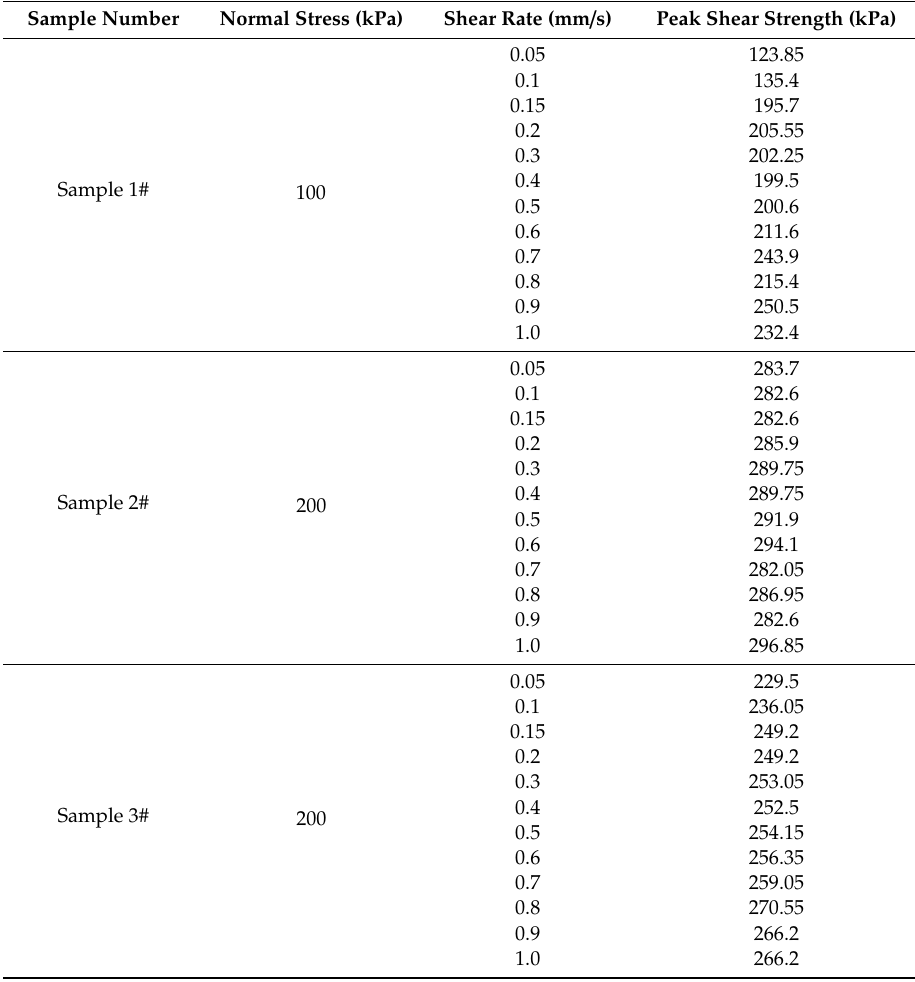
Table A1. Peak shear strength of granite discontinuity samples under di ff erent normal stresses and shear